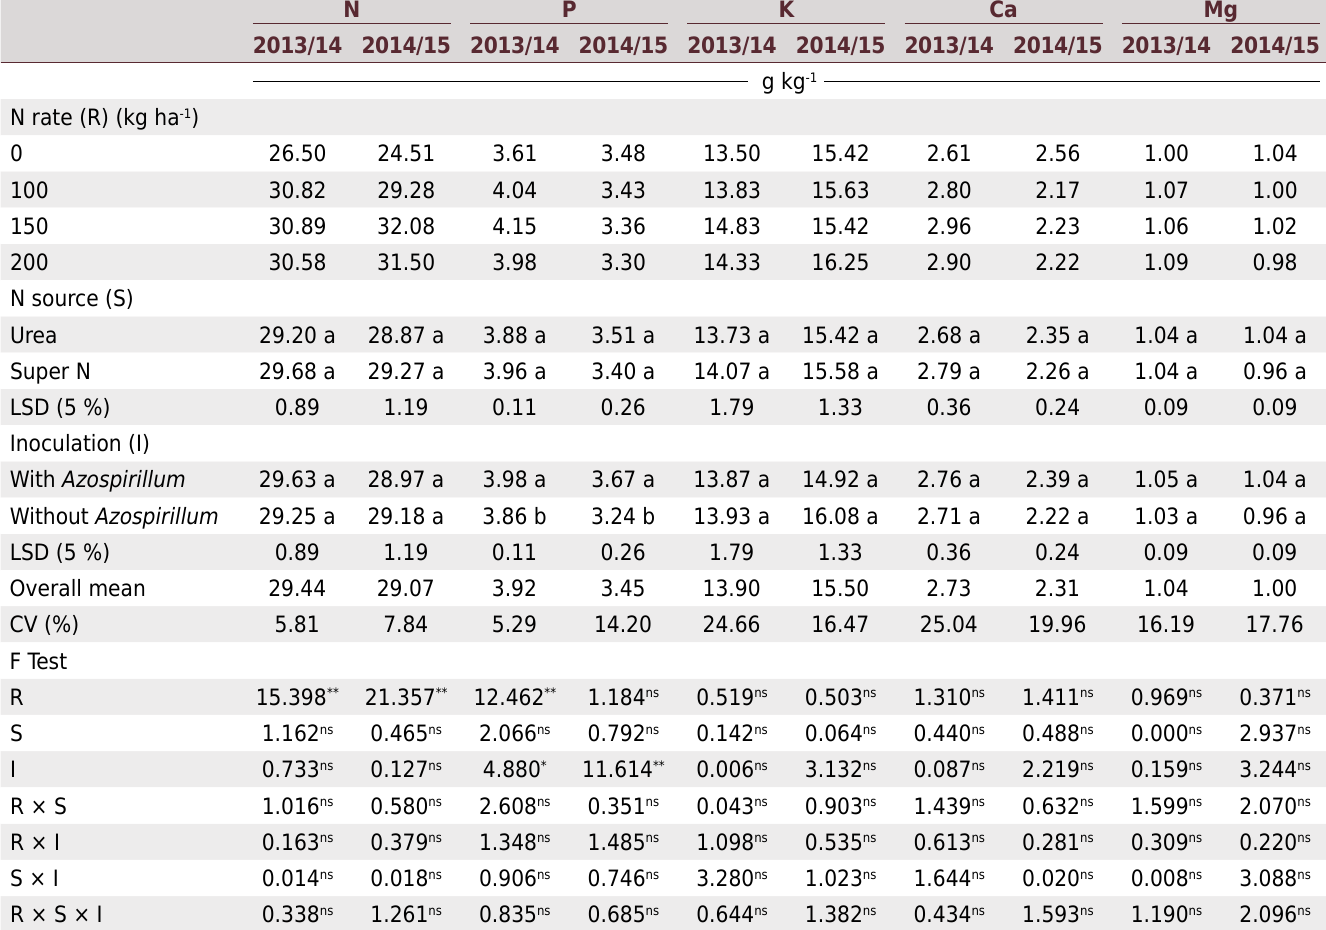
Table 1. Means and Tukey test concerning nitrogen, phosphorus, potassium, calcium, and magnesium leaf concentrations of corn affected by rates and sources of nitrogen, with or without inoculation by Azospirillum brasilense (2013/14 and